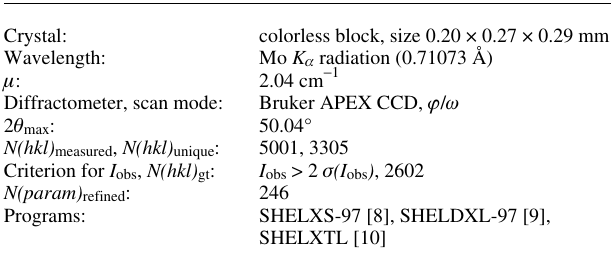
Table 1. Data collection and